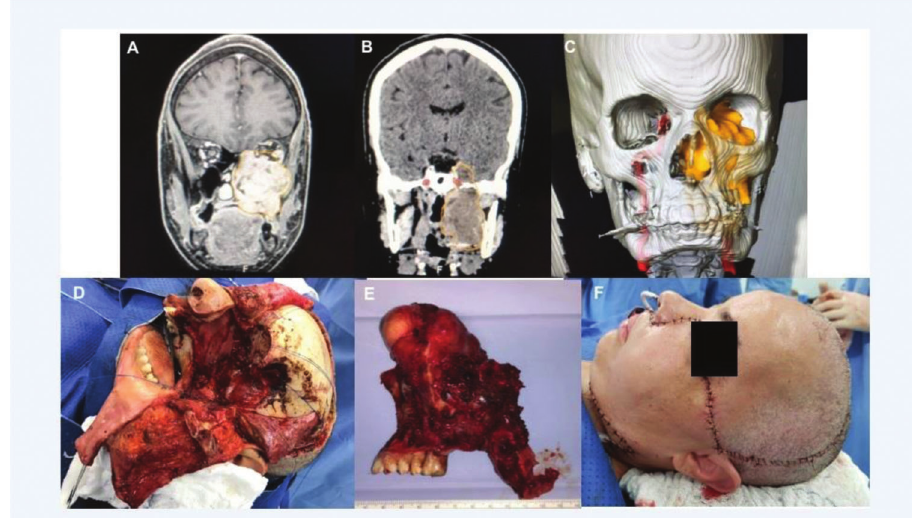
Figure 1 - An extensive adenoid cystic carcinoma with skull base invasion submitted to craniofacial resection and microsurgical free flap reconstruction. No major complications. Images A, B, and C show preoperative scans showing a large tumor involving the maxilla and middle fossa; D, the surgical defect after en bloc tumor resection; E, the surgical specimen; and F, the immediate result after